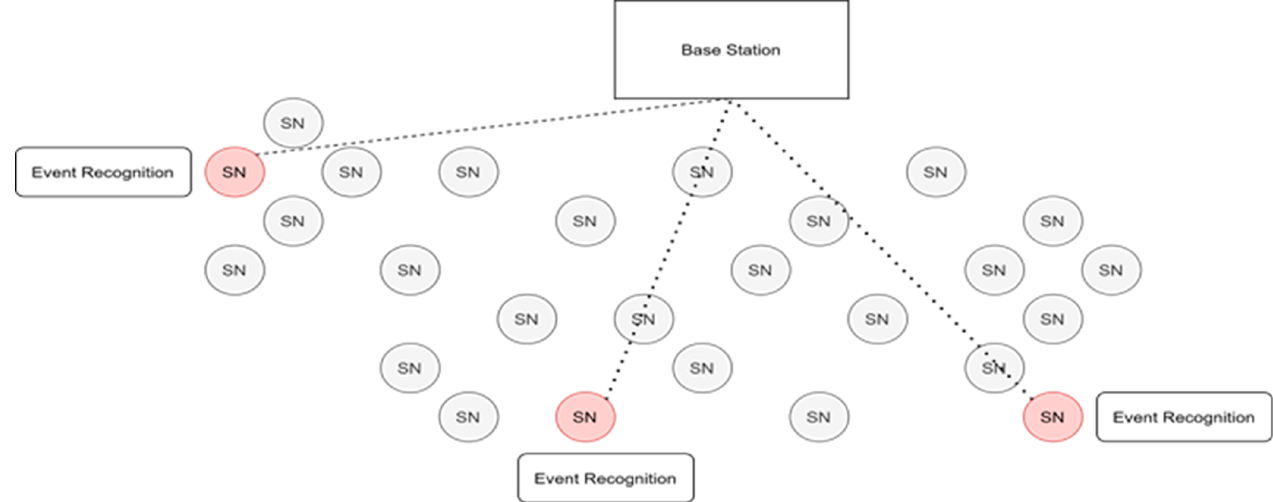
Figure 4. Direct/1-tier communication in WSN.